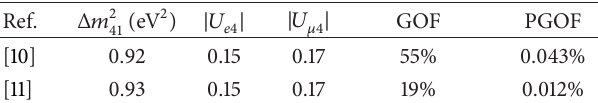
Table 5: The best fit values from 3 + 1 global fits to the world neutrino data from [10, 11]. Also the goodness of fit probability (GOF) and the parameter goodness of fit probability (PGOF) [36] are